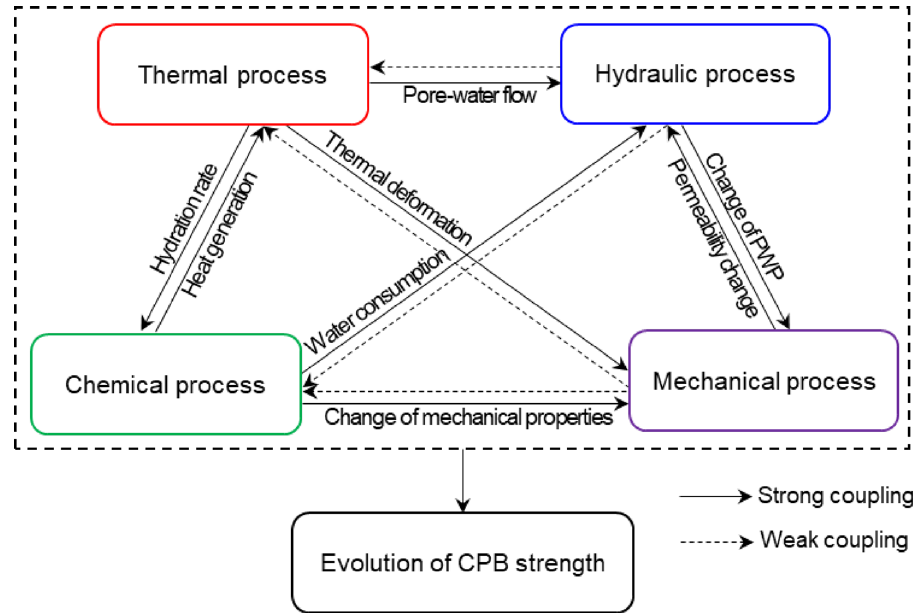
Fig. 1 Schematic diagram of primary controlling mechanisms of changes to CPB